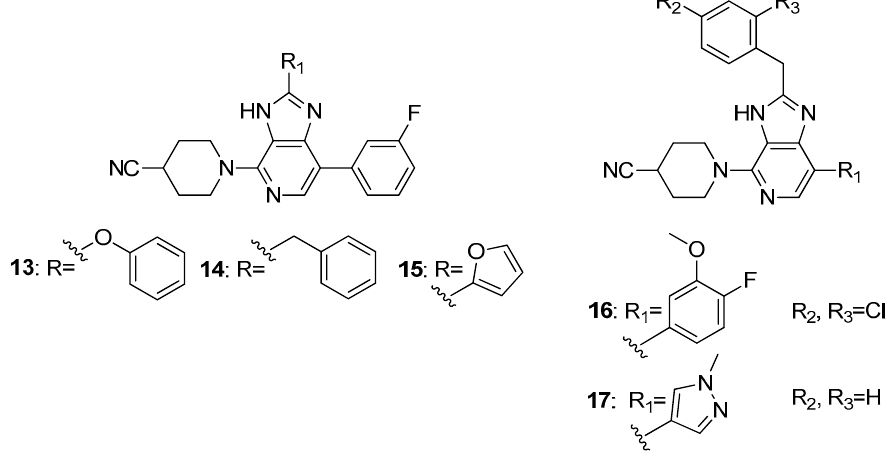
Figure 6. Antifungal imidazo[4,5- c ]pyridines.